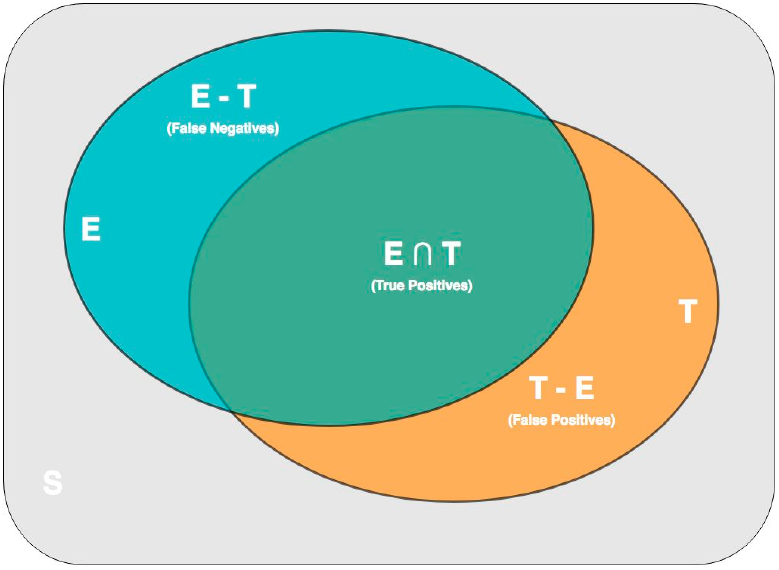
Figure 1. Problem definition.